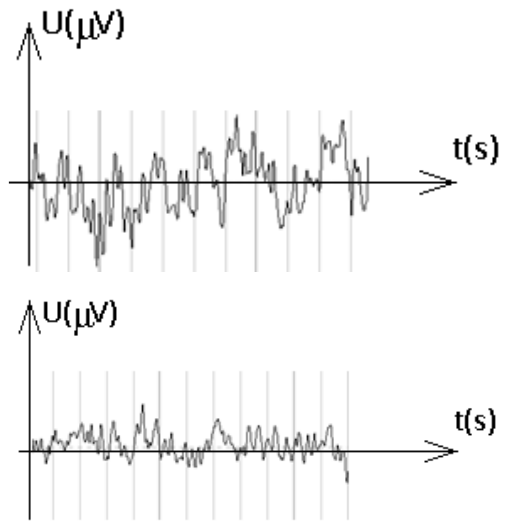
Fig 6 . Hands squeezing. Top – original, bottom – corrected.